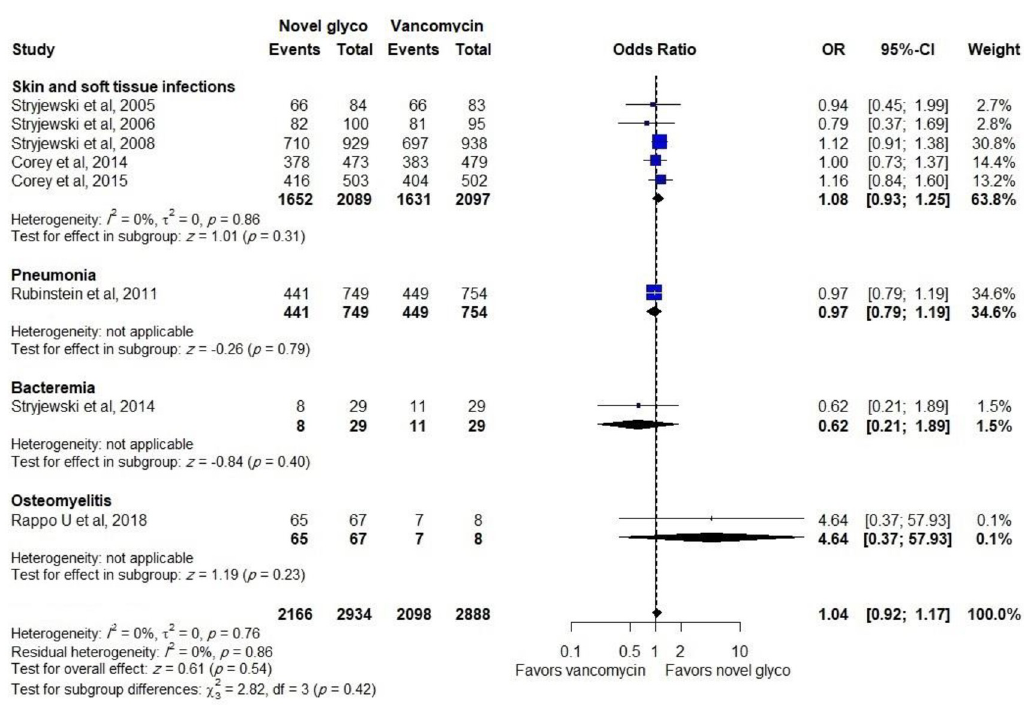
Fig 2. Clinical response of novel glycopeptides against vancomycin in the modified intent-to-treat